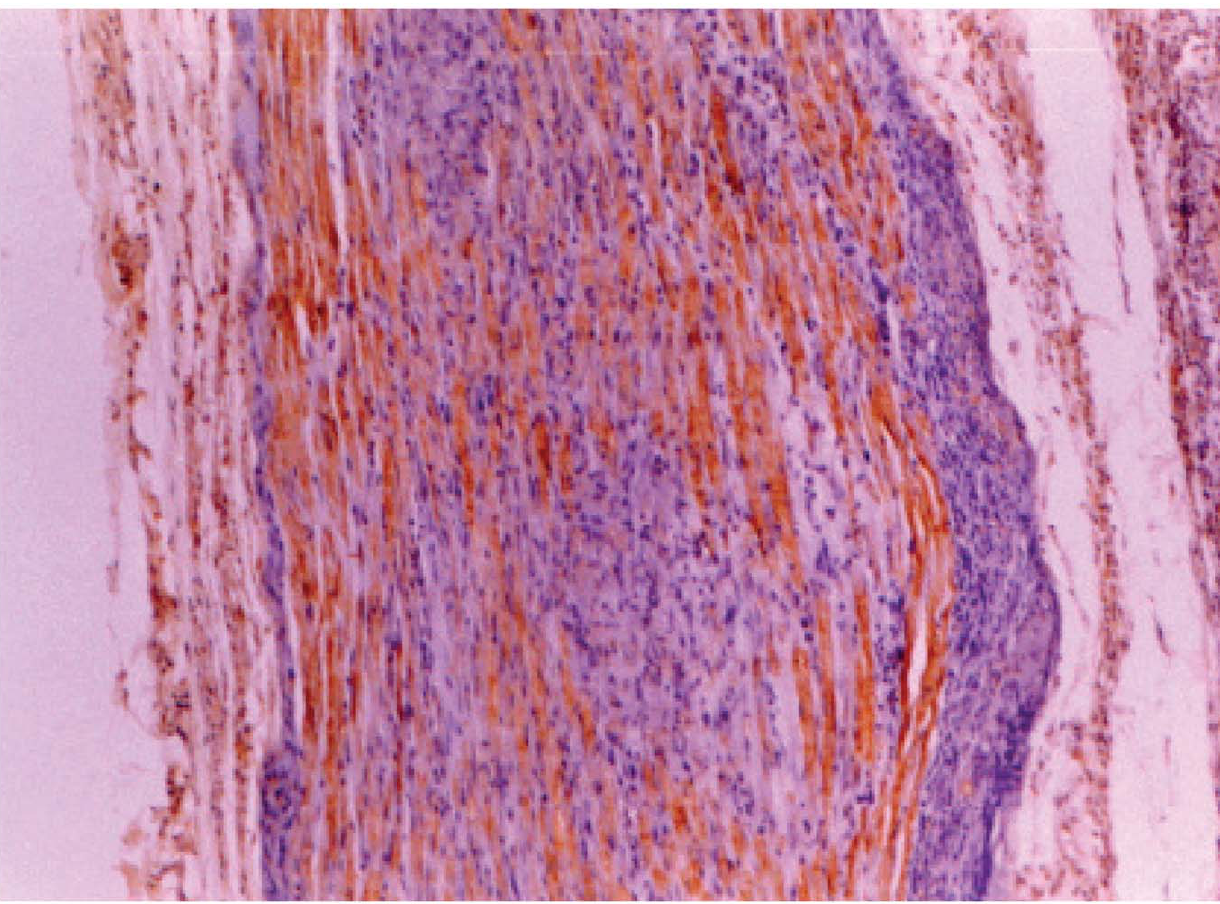
Figure 9. Nerve stained with S100. Nerve showing S100 positive areas of staining of intact fibers and areas of absence of stain in segments of nerve destruction. IHC staining 6 20.